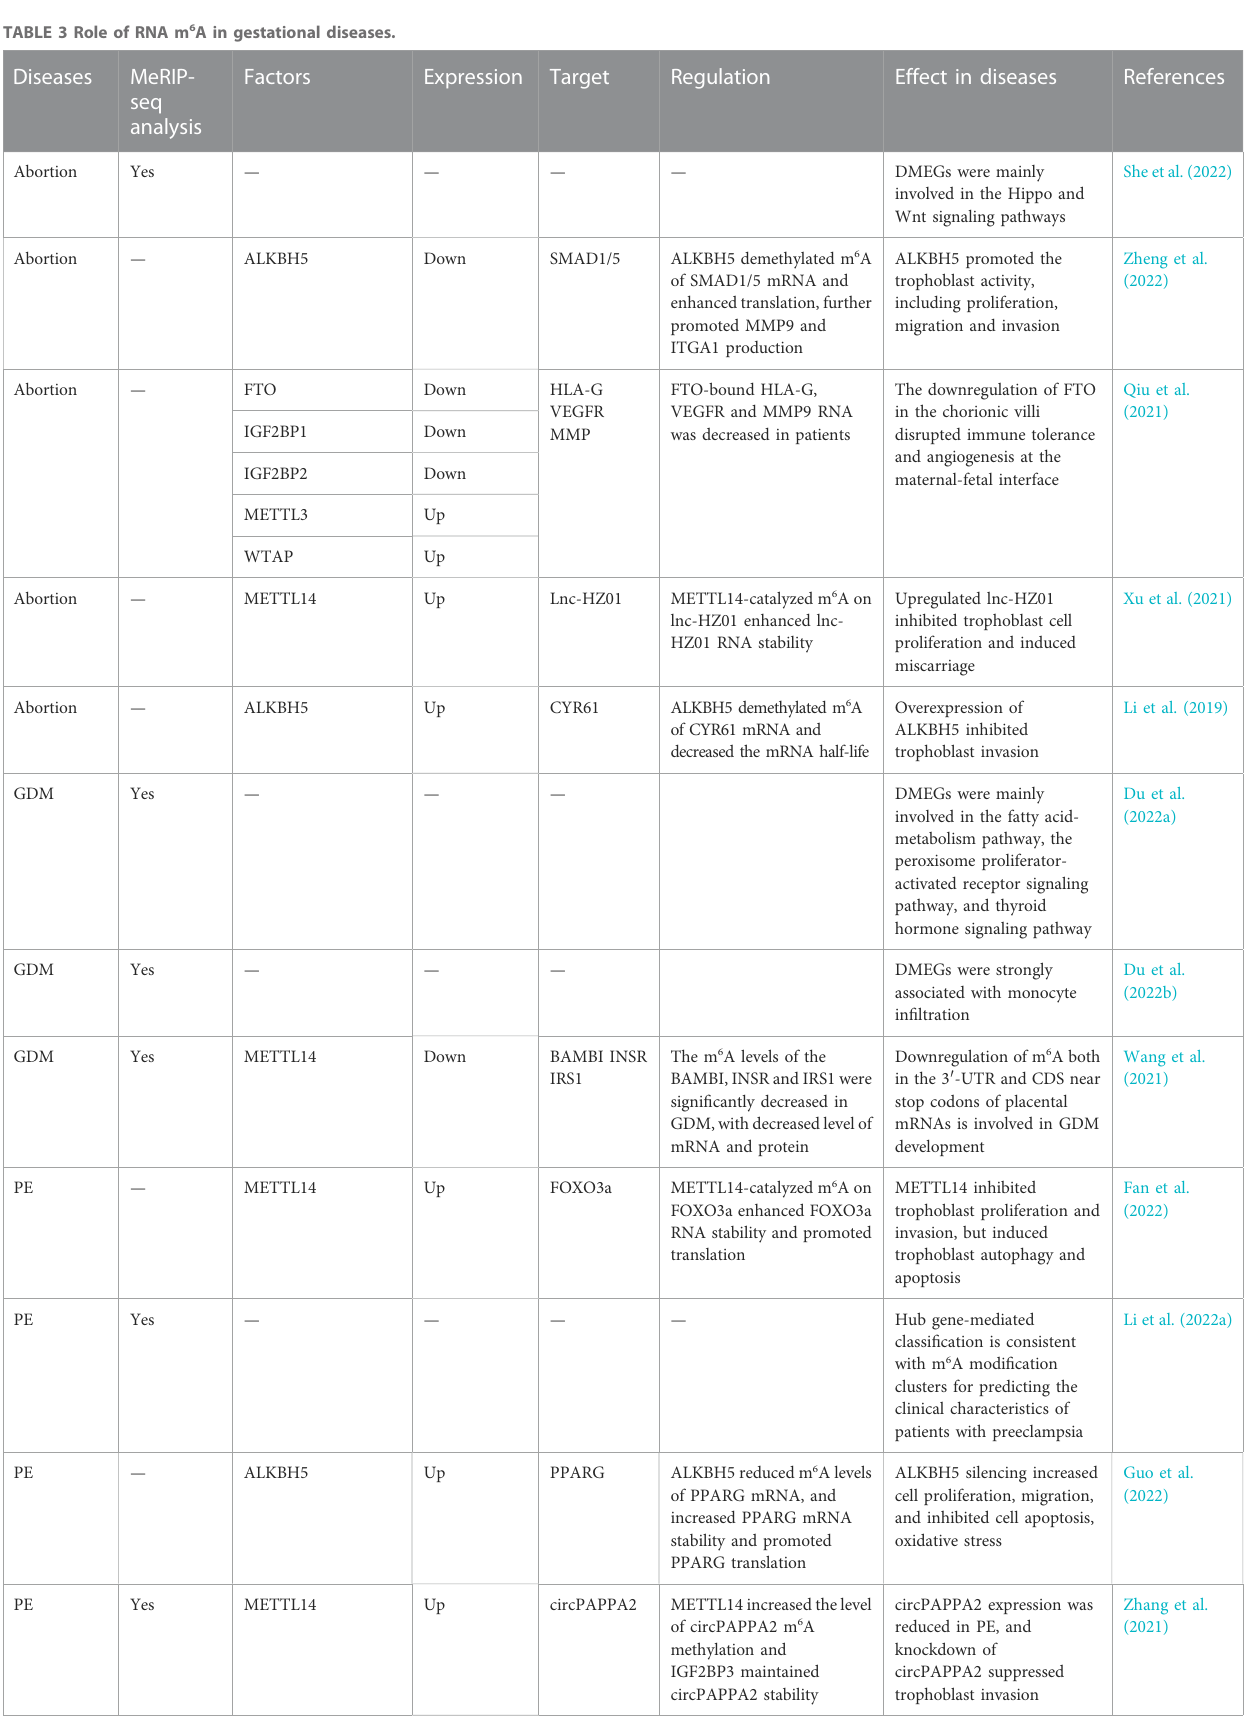
TABLE 3 Role of RNA m 6 A in gestational